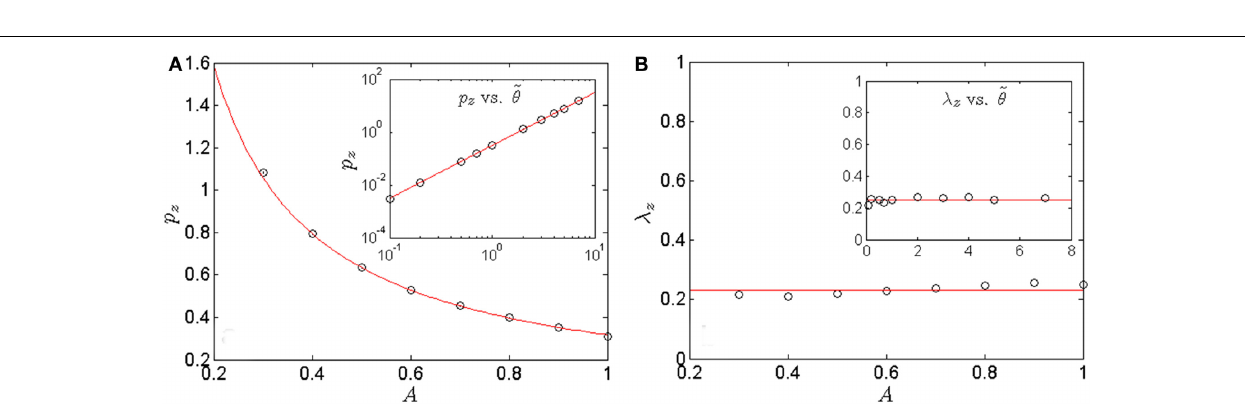
FIGURE 9 | Structure function S z ( (cid:4) z ) measured along z : (A) for various system sizes N at A = 1 and ˜ θ = 1, (B) for various ˜ θ at A = 1 and N = 1024, and (C) for various A at ˜ θ = 1 and N = 1024. The ordinate axis is logarithmic. For all figures, the straight lines correspond to the solutions of Equation 14.